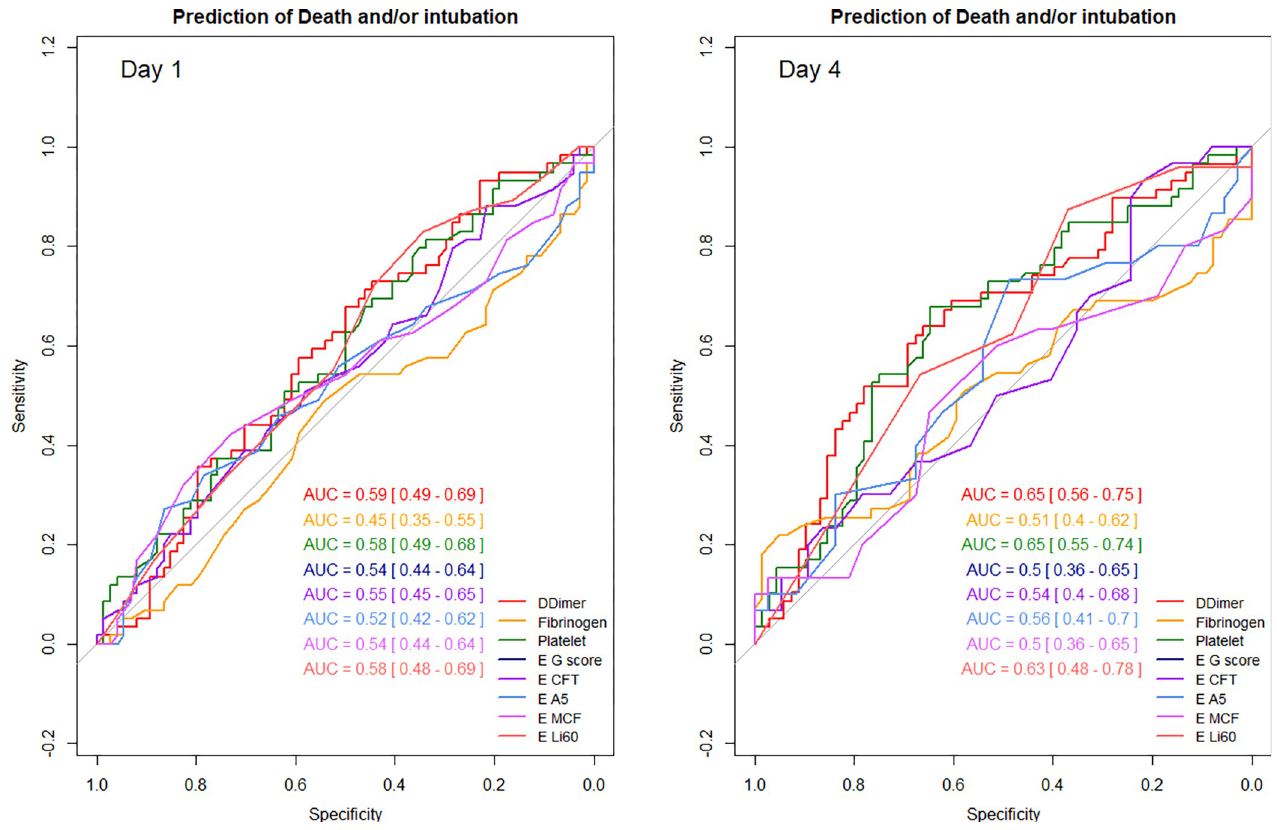
Fig 6. Prediction of intubation and/or ICU death by coagulation indices on day 1 and day 4. AUC: Area Under the Curve; E: EXTEM; CFT: Clot formation time; A5: Clot amplitude 5 minutes after clotting time; MCF: Maximum clot firmness; Li60: Lysis index at 60 minutes.